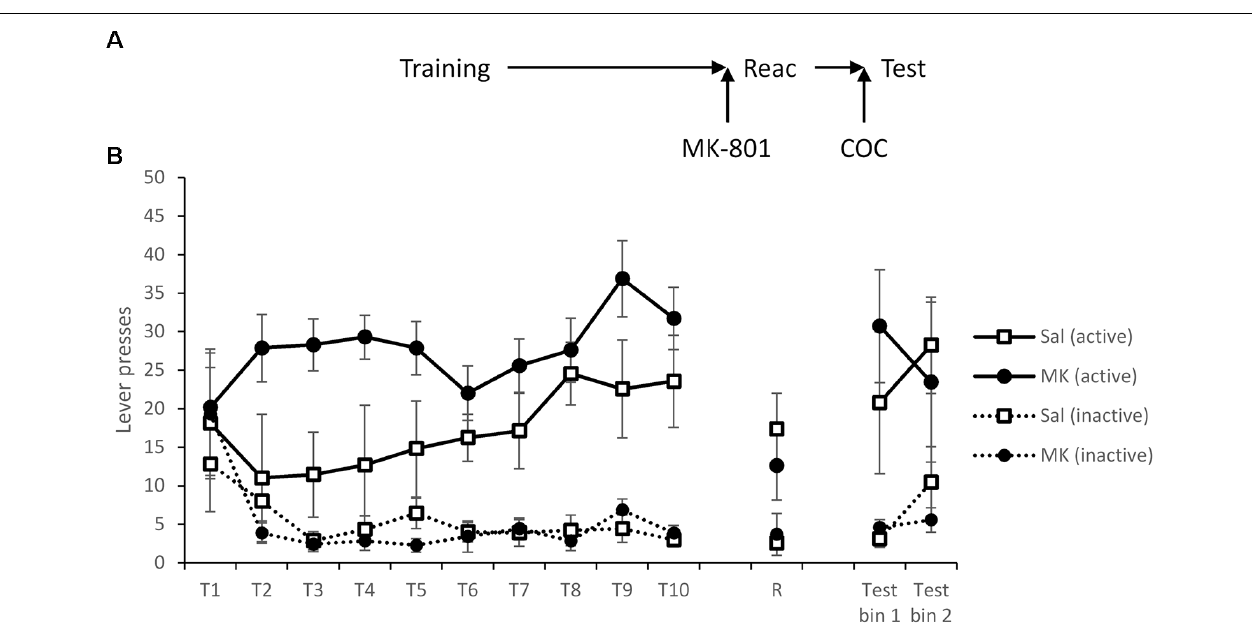
FIGURE 5 | Administration of a cocaine-priming injection successfully rescued lever pressing on the active drug-lever, following MK-801 induced disruption of reconsolidation. (A) Schematic of the experiment. (B) Rats acquired cocaine-seeking successfully over the training period (T1–T10), although there were differences between the groups. At reactivation (R), overall lever pressing was slightly reduced by MK-801 administration ( n = 7), although this was not significantly different to saline controls ( n = 9). Immediately prior to testing rats were injected with 10 mg/kg cocaine, which subsequently rescued responding on the active lever in the MK-801 group. There was no difference at test between the groups, even when corrected for training history. Data are presented as summary mean ±